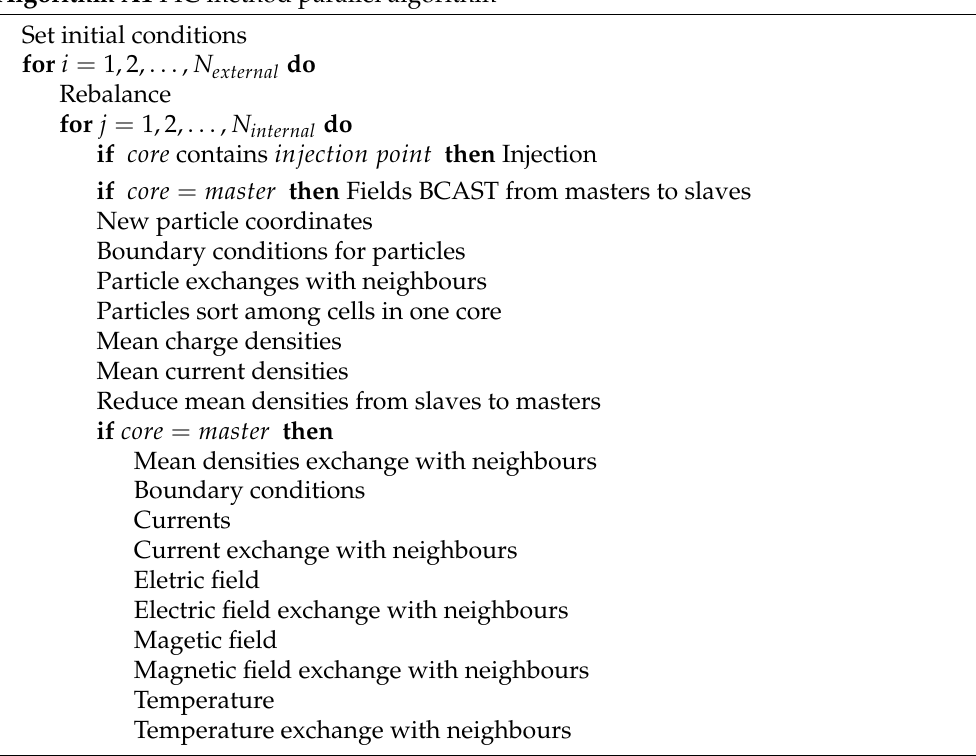
Algorithm A1 PIC method parallel